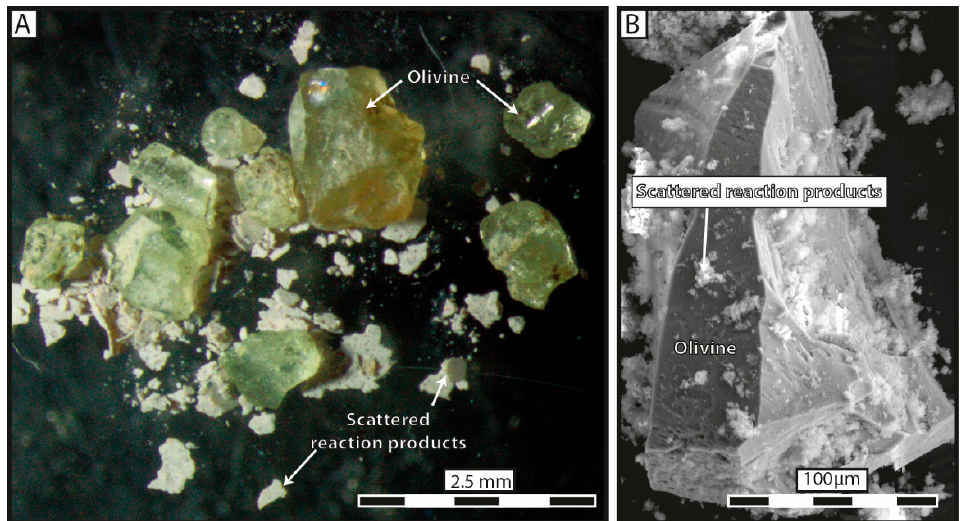
Figure 7. Olivine grains after reaction in NaHCO 3 solution. ( A ) Optical micrograph showing a highly fragmented olivine grain and widespread scattering of the reaction products. ( B ) Secondary electron image displaying small aggregates of reaction products scattered onto an olivine fragment. ( A ) is for t = 12 months (run # 3), and ( B ) for t = 6 months (run # 2).